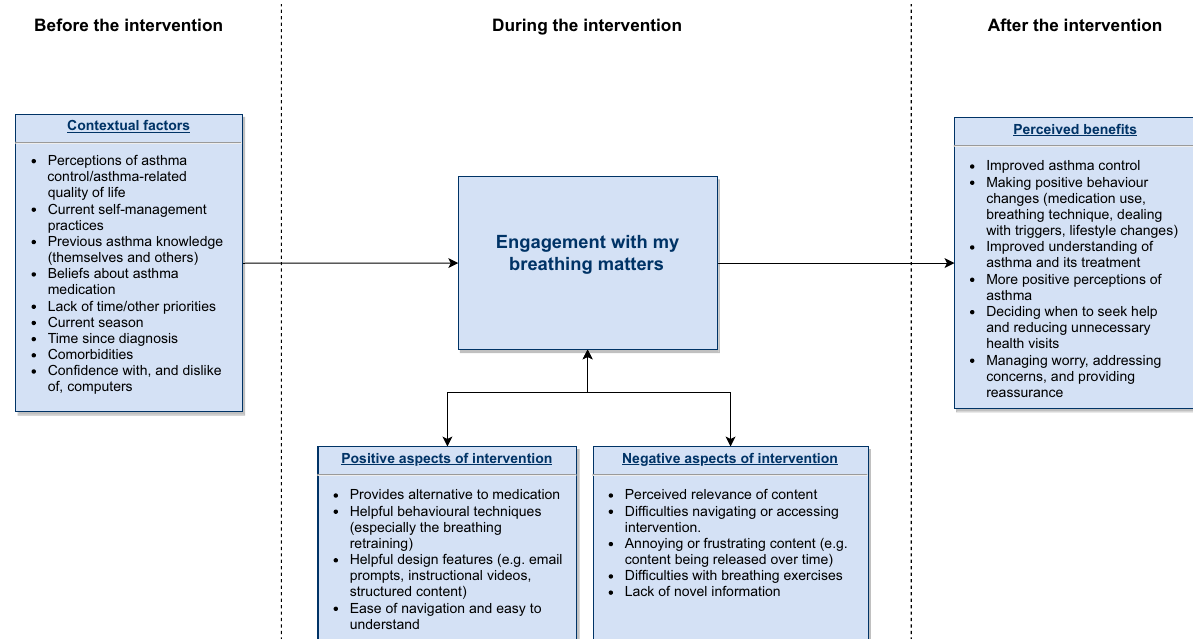
Fig. 4 Summary of the qualitative fi ndings. Demonstrating the contextual factors and aspects of the intervention content and delivery that may in fl uence engagement with My Breathing Matters and the perceived bene fi